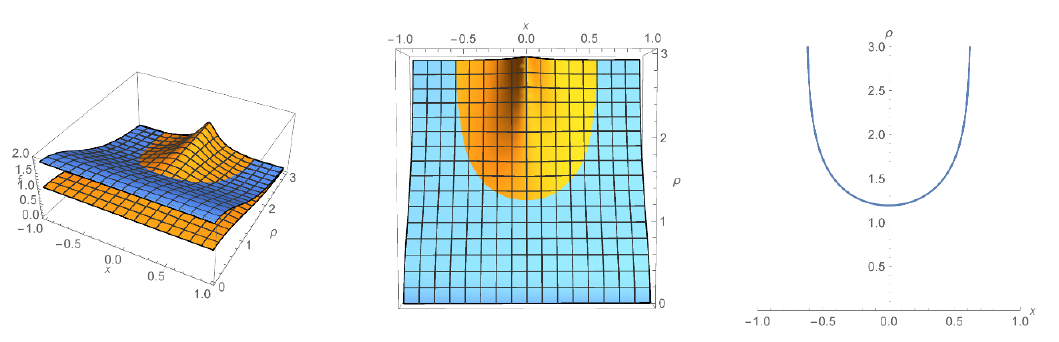
Figure 1 . Surfaces (3.25) with c 2 = 0 ; m = 1, orange and (3.26) with c 1 = 1 : 8, blue (left); the same surfaces viewed from above (centre); the curve (3.27)